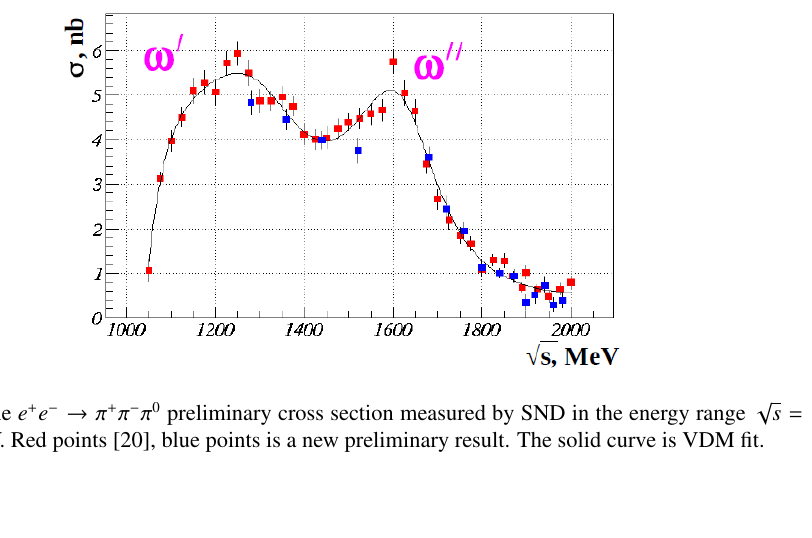
Figure 5. The e + e − → π + π − π 0 preliminary cross section measured by SND in the energy range 1 . 05 – 2 GeV. Red points [20], blue points is a new preliminary result. The solid curve is VDM fit.